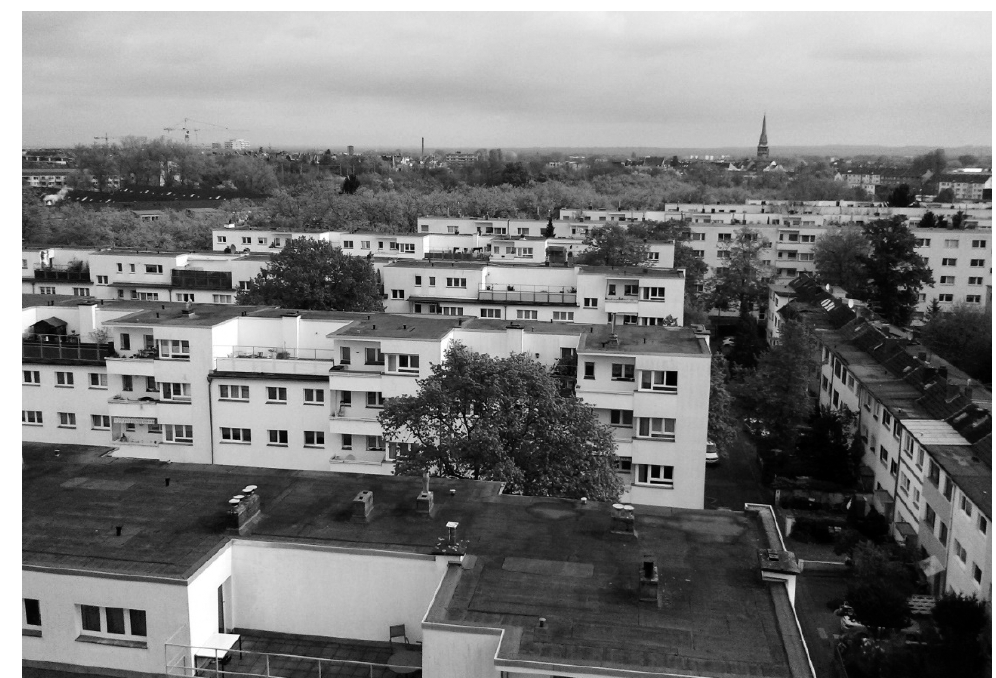
Figure 17. W. Riphahn, Cologne-Buchforst, Weisse Stadt (1929–1930). Source: Hatzfeld (2017). The neighbourhood planning also included the con-